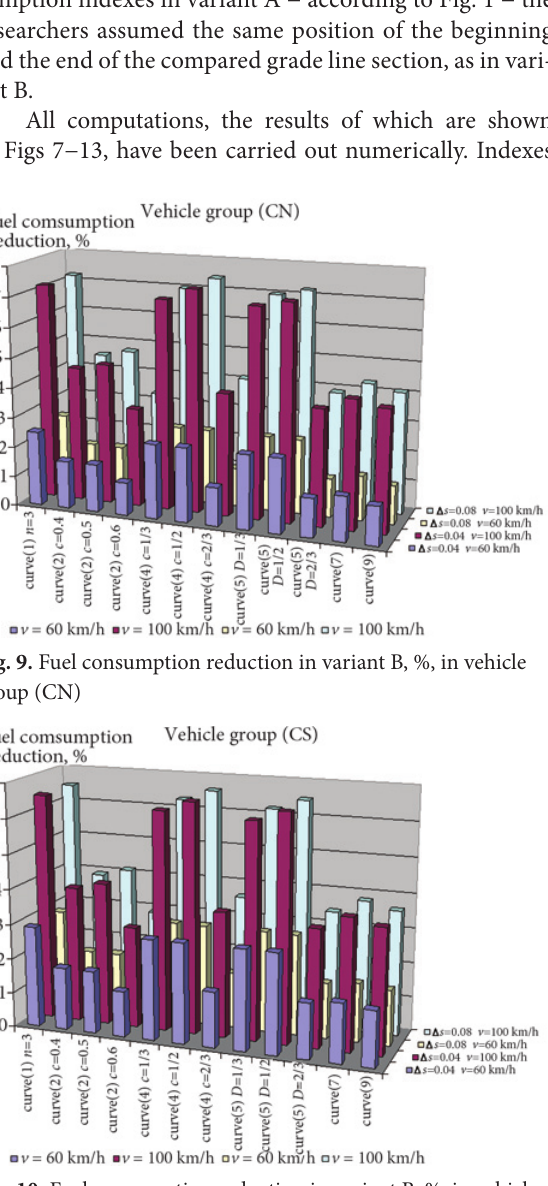
Fig. 10. Fuel consumption reduction in variant B, %, in vehicle group